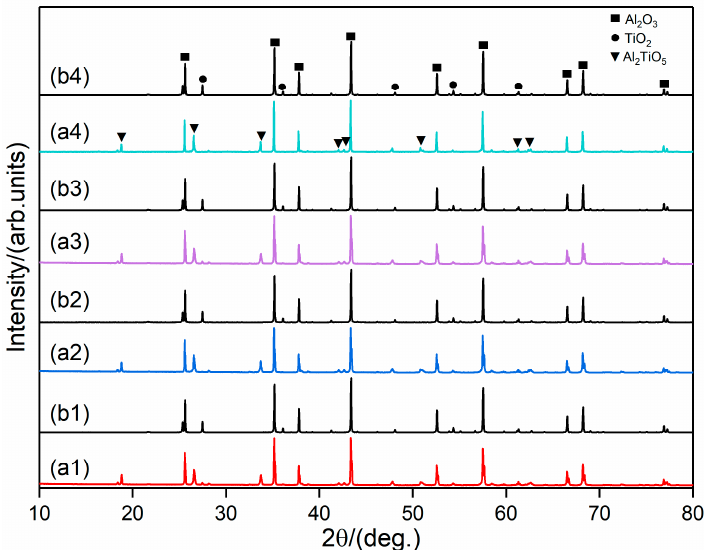
Figure 10. XRD patterns of 0.9 Al 2 O 3 -0.1 TiO 2 samples sintered at ( a1 ) 1400 ◦ C, ( a2 ) 1500 ◦ C, ( a3 ) 1550 ◦ C, and ( a4 ) 1600 ◦ C. ( b1 – b4 ) are post-annealed samples of ( a1 – a4 ), respectively.